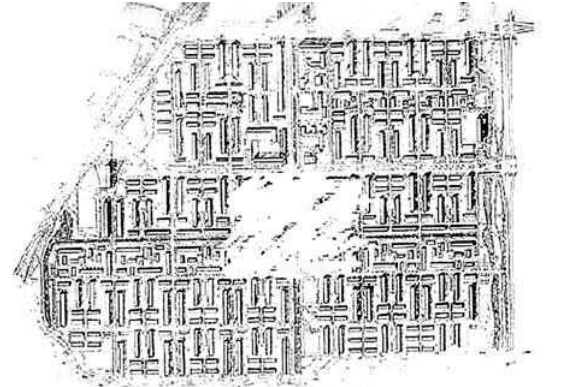
Fig 2. Pendrecht residental district in Rotterdam,